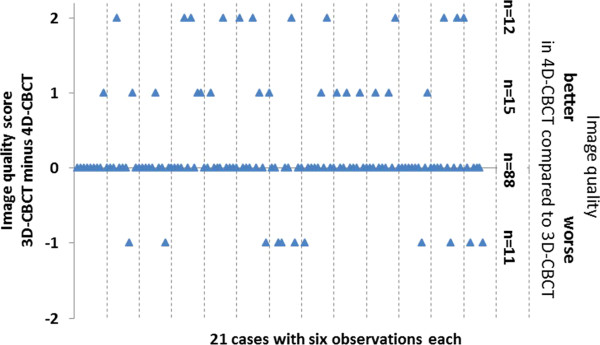
Comparison of image-quality in 3D-CBCT and 4D-CBCT for all 21 cases and 6 observers individually.